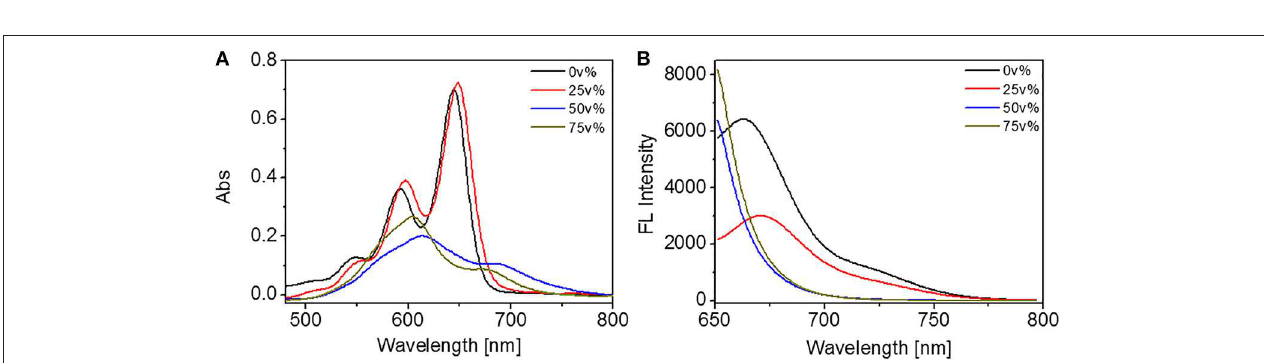
FIGURE 2 | (A) UV absorption and (B) FL emission spectra of DUO-TDI in solutions of water/THF. The concentration of all mixed solutions was 5.4 × 10 − 6 M. The excitation wavelength was 644nm for all samples.